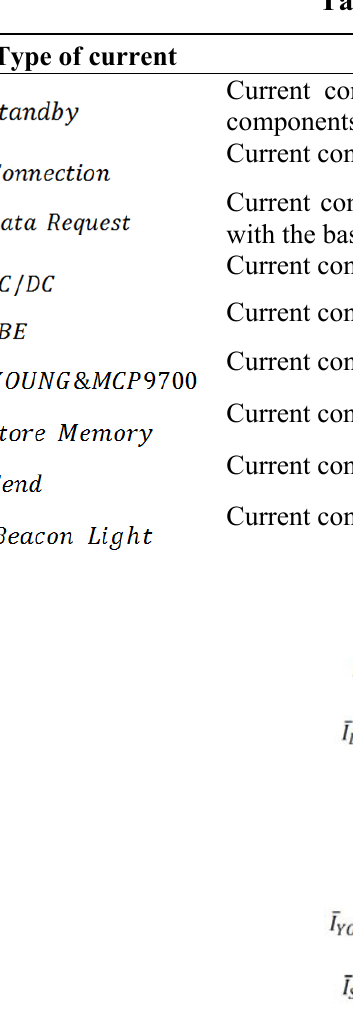
Table 3. Description of current